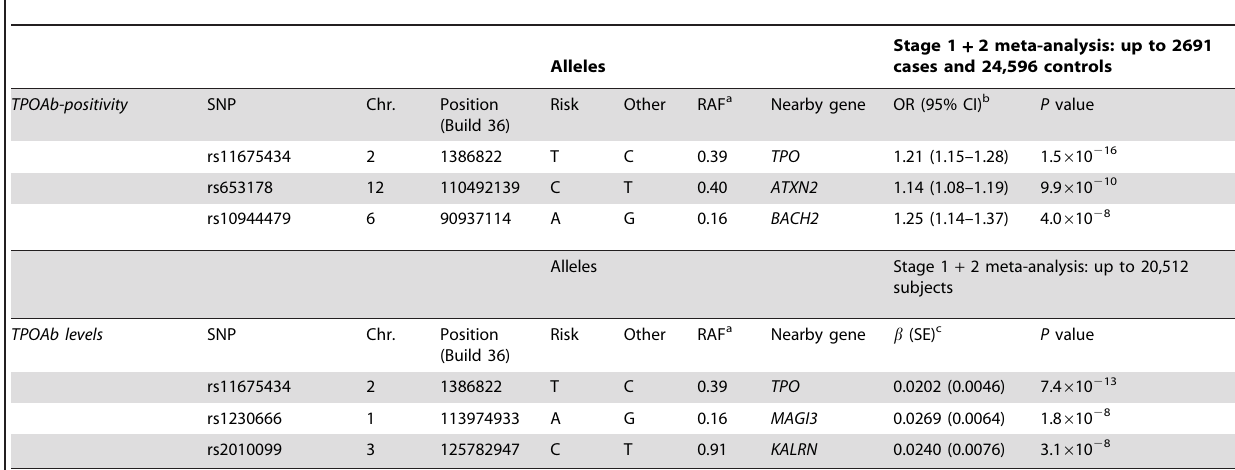
Table 2. Newly identified loci associated with TPOAb-positivity and/or serum TPOAb levels reaching genome wide significance.